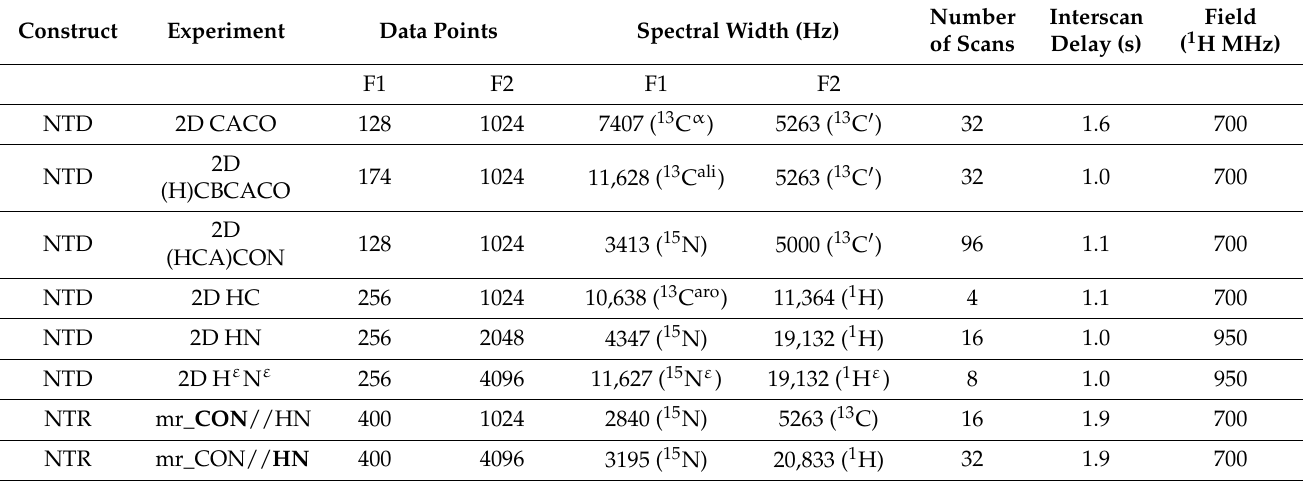
Table 1. Acquisition parameters for the recorded